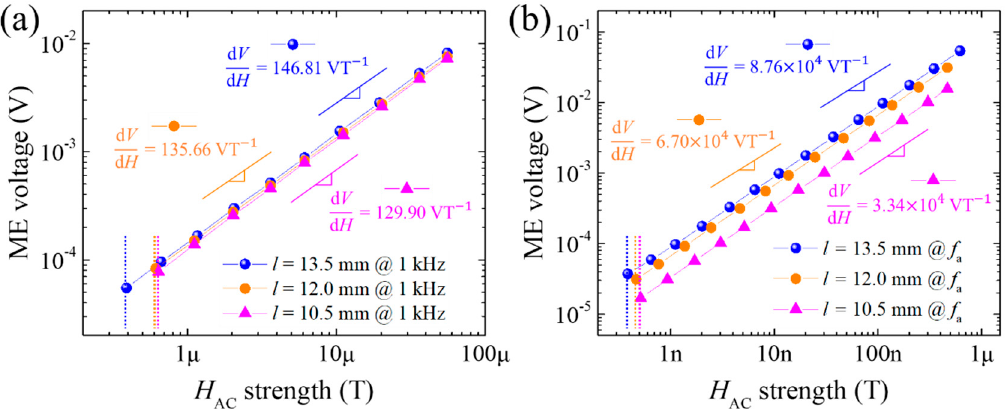
Figure 6. Magnetoelectric voltage output as a function of H AC of PZT-PMS sensors with different lengths (FE cross-sectional dimensions: 3.0 mm ( w ) × 1.0 mm ( t )): ( a ) measured at 1 kHz and ( b ) measured at an anti-resonance frequency of the sensors. Slope values and dashed lines indicate magnetic field sensitivities and observed sensing limits, respectively.